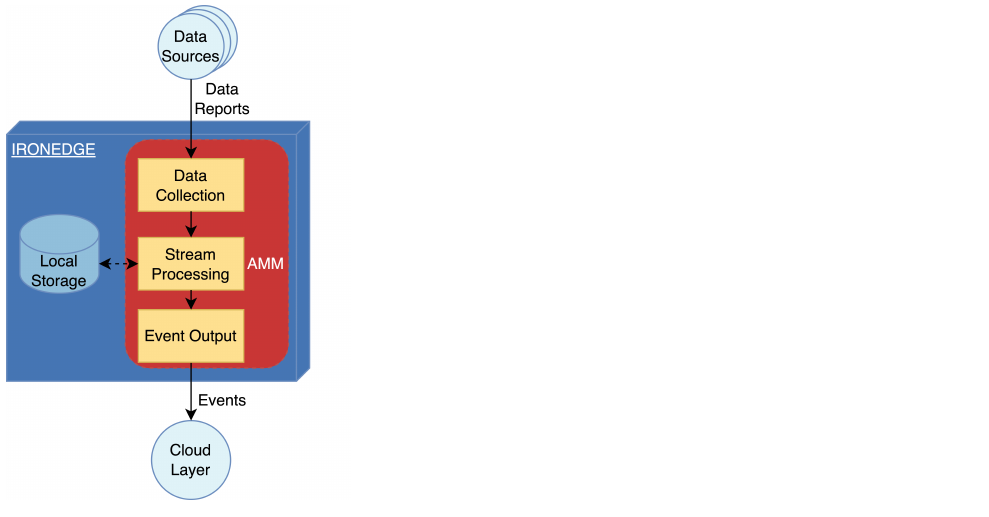
Figure 2. High-level overview of the proposed framework, identifying the fundamental set of components: Data Collection, Stream Processing, Local Storage, Event